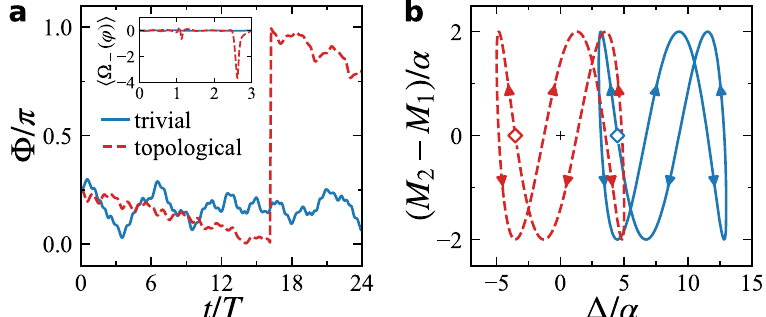
Fig. 4 Dynamic evolution with the mismatched pump frequencies. a Evolution of Φ for ν 0 ¼ ν = 3 . The blue-solid (red-dashed) lines correspond to the trivial (topological) pump. The inner panel shows the evolution of 〈 Ω − ( φ ) 〉 . The period of the pump cycling changes to 3 T when ν 0 ¼ ν = 3 . We set φ 0 = 3 π /4 and Φ i = π /4. Other parameters are the same with Fig. 2. b The corresponding trajectories in the parameterized plane.